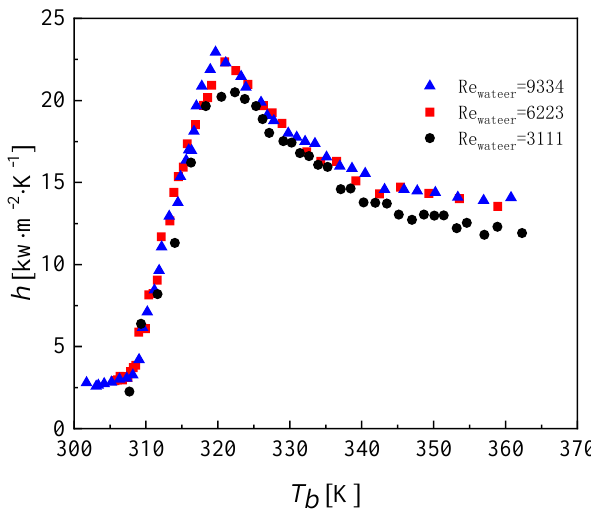
Figure 18. Variation in the heat transfer coefficient of CO 2 at different water mass fluxes.